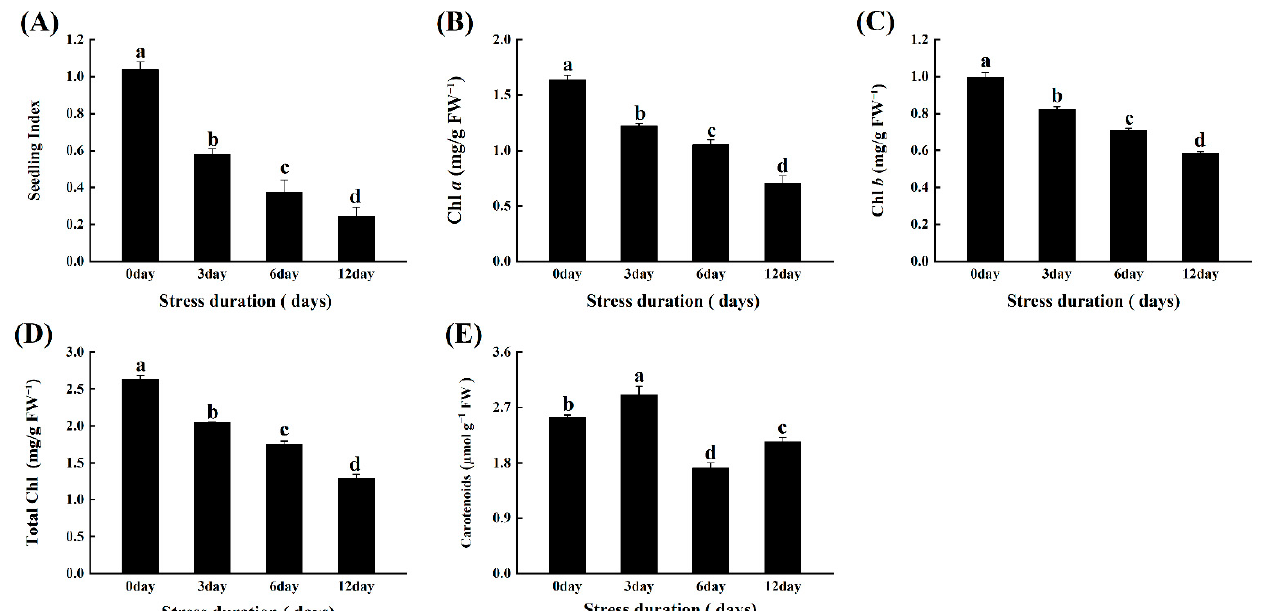
Figure 1. Effects of salt stress on ( A ) seedling index; ( B ) Chla; ( C ) Chlb; ( D ) Total Chl and ( E ) Carotenoids in leaves of tomato seedlings grown for 12 days under control and salt stress. Values are mean ± SD (Standard Deviation) of three replications. Different letters indicate significant difference at p ≤ 0.05 (Tukey’s HSD test).